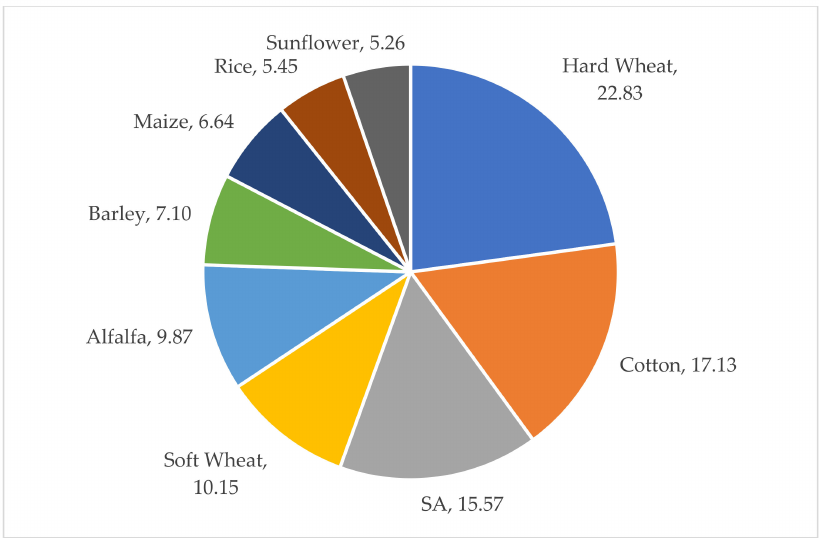
Figure 2. Distribution (%) of the main crops of the region of Central Macedonia (2018)